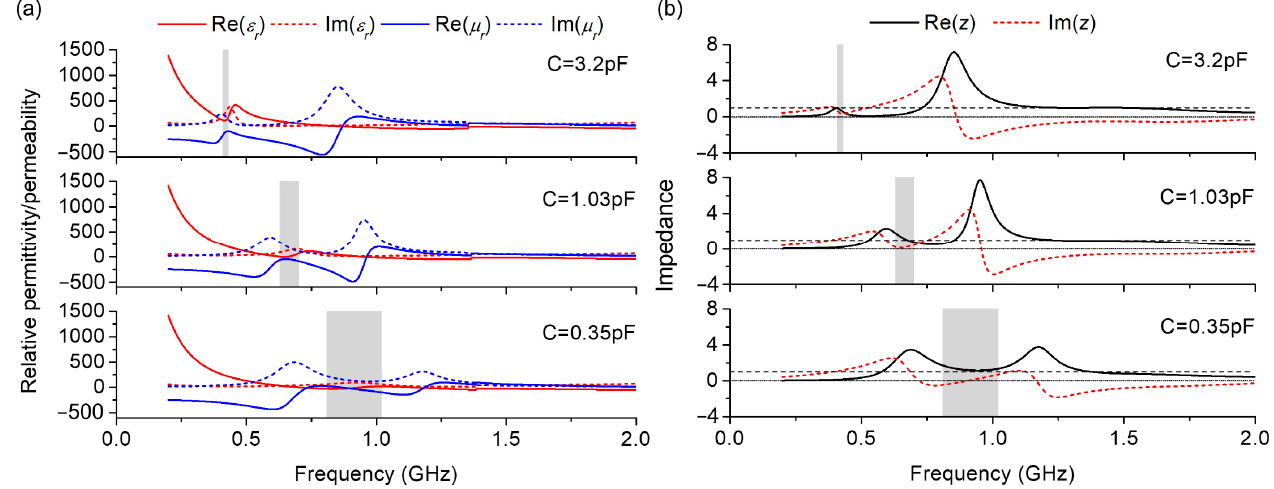
Figure 7. Retrieved ( a ) constitutive parameters and ( b ) effective wave impedance for different loaded capacitors of the absorber.